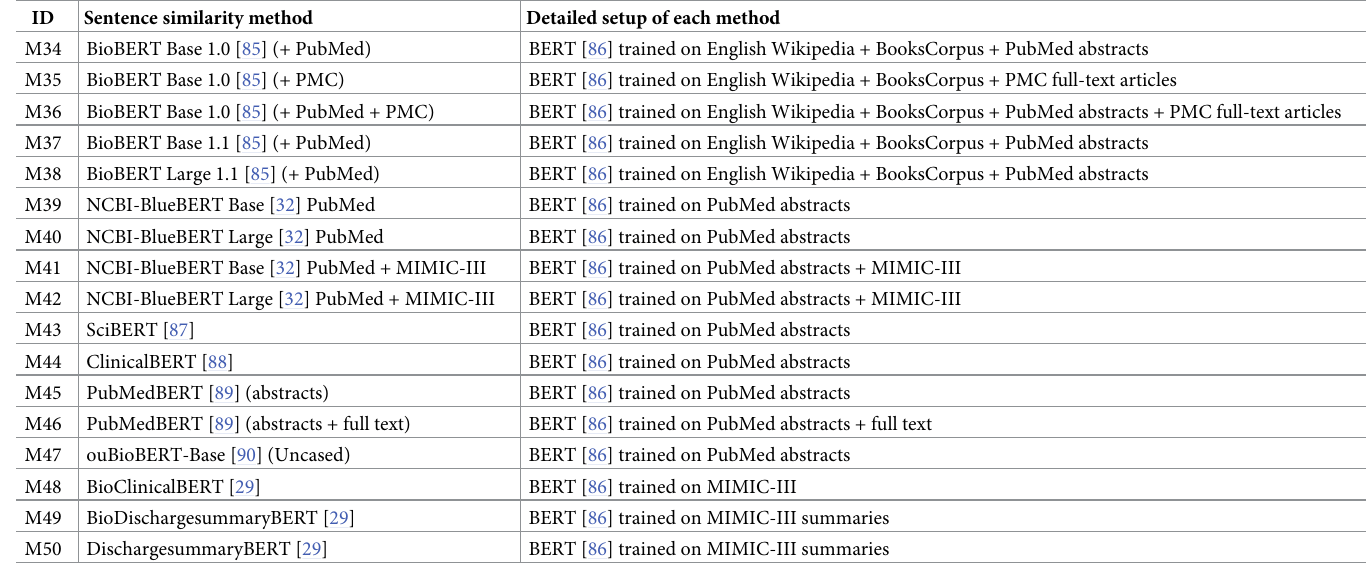
Table 5. Detailed setup for the sentence similarity methods based on pre-trained language models evaluated in this work.